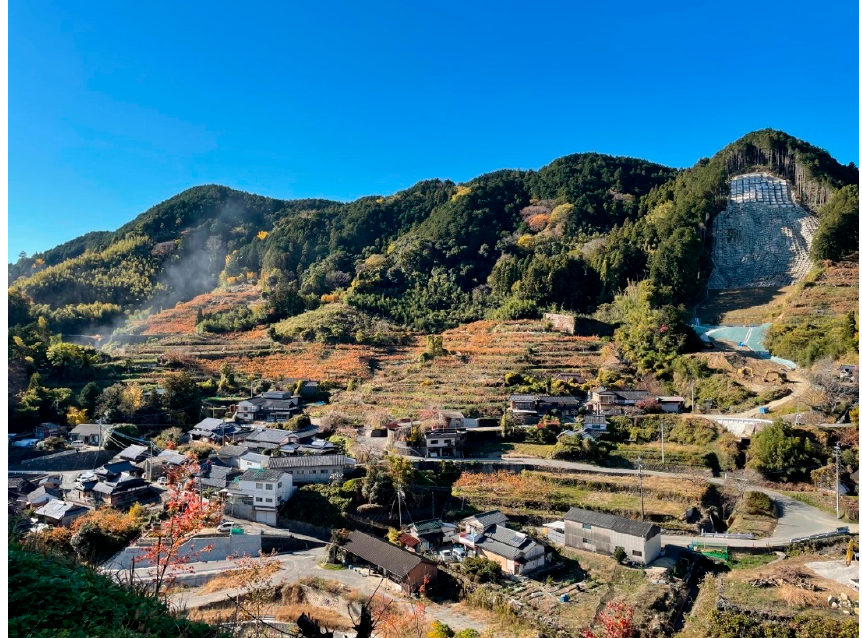
Figure 9. Landscape from the Kunugiyama observation site (obtained by Yoshio Harada [the first author] on 28 November 2021). Table 9. Opinion on the Kunugiyama observation site as the local landscape of the community. Landscape Like